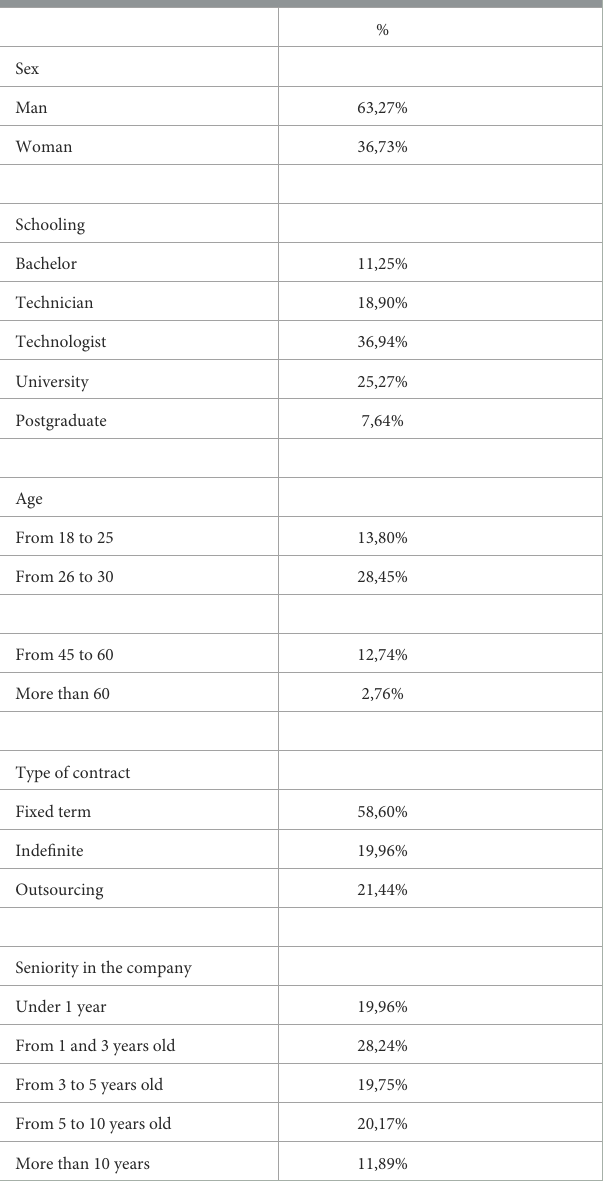
TABLE 1 Description of the